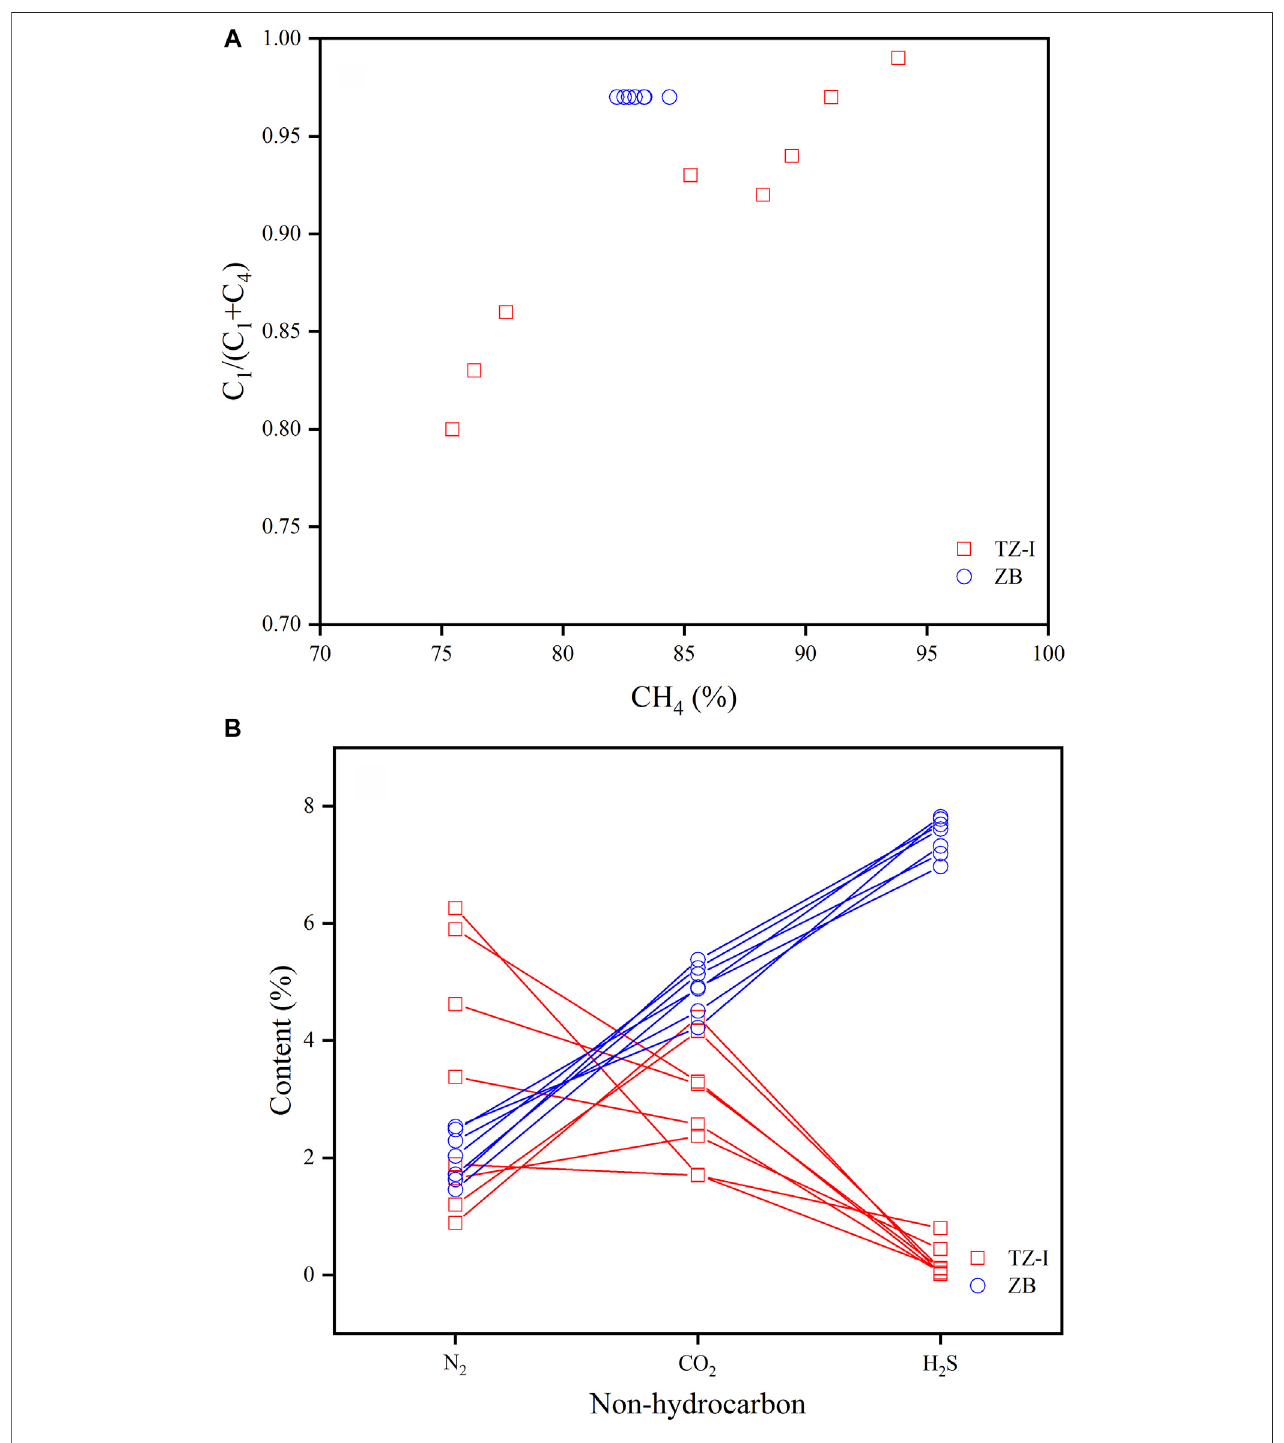
FIGURE 3 | The correlation of C 1 /C 1-4 -CH 4 % (A) and N 2 %-CO 2 %-H 2 S% (B) of natural gases in the TZ-I and ZB gas fi elds.